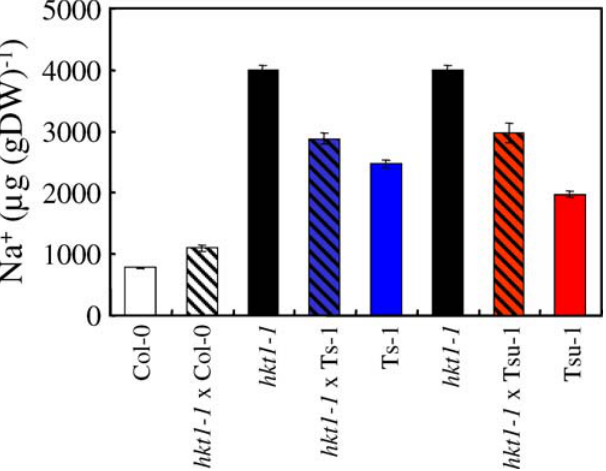
Figure 3. Complementation Studies Indicate At HKT1 Natural Variant Is Responsible for the Higher Na þ Content in Shoots of Ts-1 and